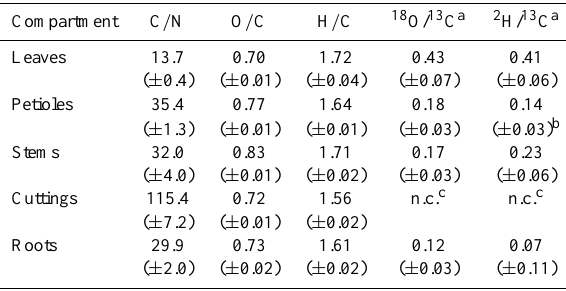
Table 3. Atomic and isotopic ratios of the labelled bulk OM. C / N, O / C and H / C atomic ratios and 18 O / 13 C and 2 H / 13 C isotopic ra- tios (of the excess atom fraction) measured in different plant com- partments after the equilibrium in the atmospheric labelling was reached. Indicated are average values of two sampling dates ( t = 8 and 14) with three plant replicates each ( ± 1 standard deviation).